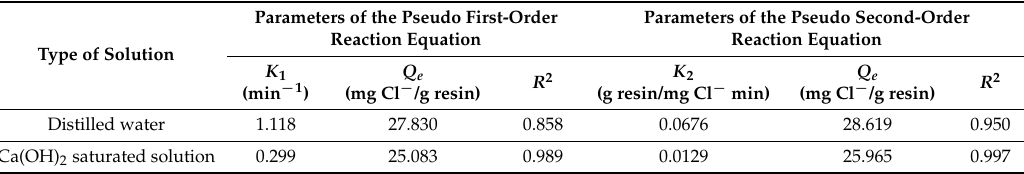
Table 7. Experimental parameters of the pseudo first-order and pseudo second-order reaction equations.